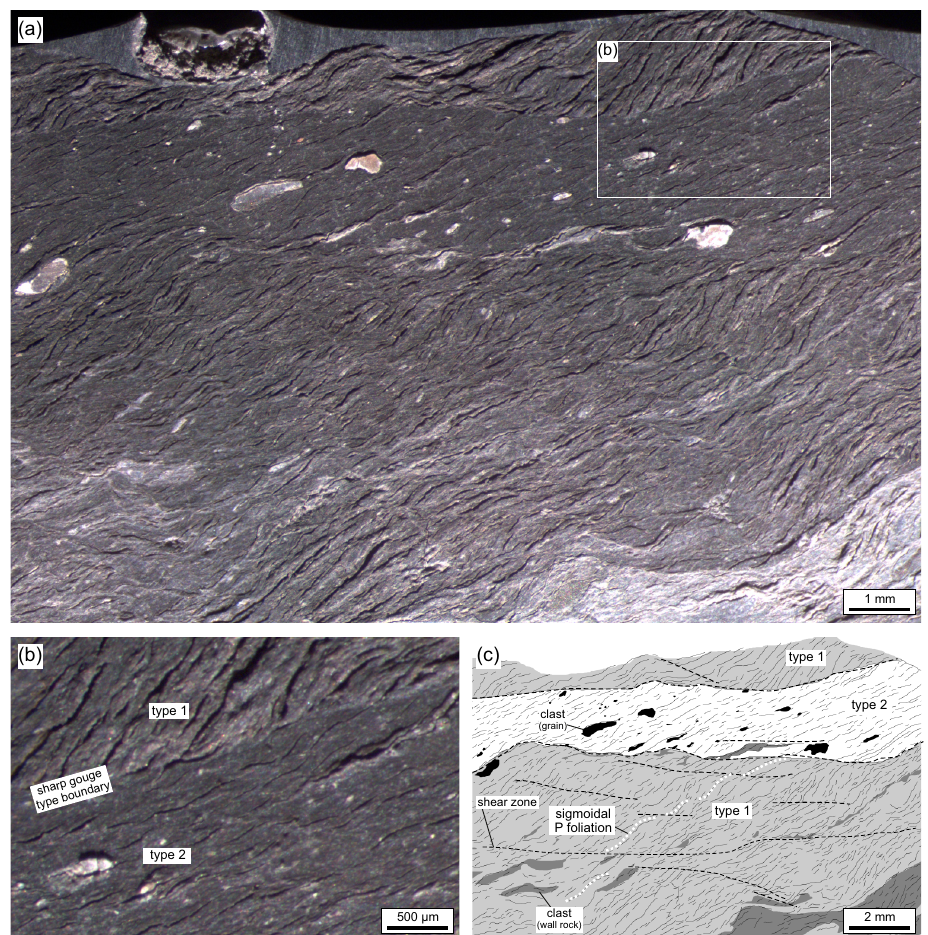
Figure 6. P-foliation patterns, grain and wall rock clasts as well as micrometer-thin shear zones in gouge. (a) Water-immersed hand specimen V17 photographed in shaded light. (b) Inset of panel (a) and (c) sketch of panel (a) . Note the S-C resembling sigmoidal P foliation and the strict boundary separating type 1 and type 2 gouge. See text for